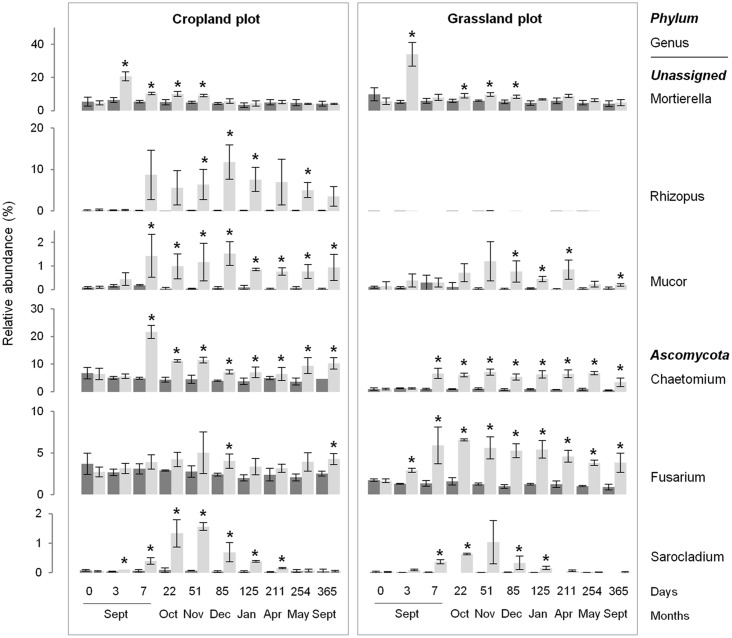
Dynamics of the relative abundance of some fungal genera over time, according to soil management history (cropland and grassland) and treatment: control (dark grey) and wheat-amended (light grey).Error bars denote standard deviation of biological replicates (n = 3). Asterisks indicate a significant difference between control and amended sub-plots at different sampling dates, according to Fisher test (P<0.05).